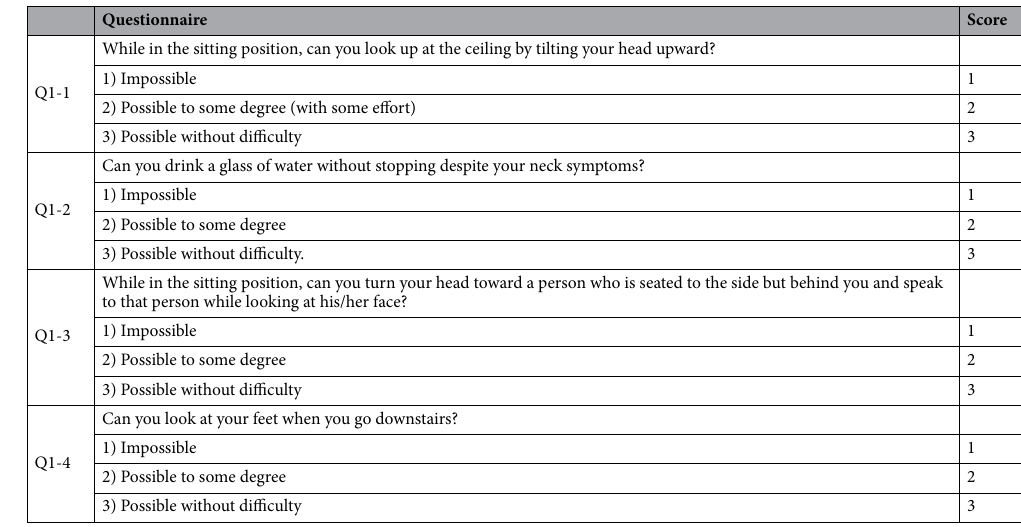
Table 1. The domain of cervical spine function in the JOACMEQ. JOACMEQ Japanese Orthopaedic Association Cervical Myelopathy Evaluation Questionnaire. The score for the cervical spine function domain was calculated as follows (points): Q1-1 × 20 + Q1-2 × 10 + Q1-3 × 15 + Q1-4 × 5 −